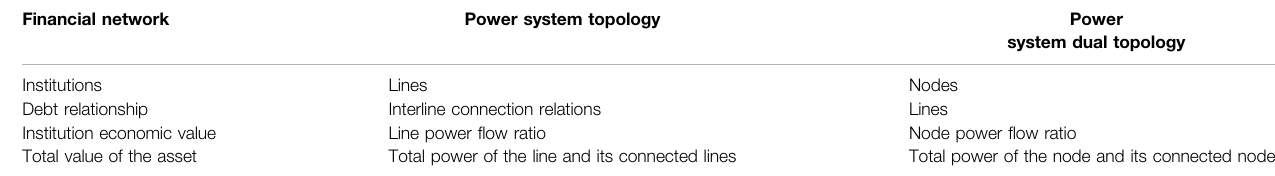
TABLE 2 | Consistent correspondence between the dual topology of the power system, the power system topology, and the fi nancial